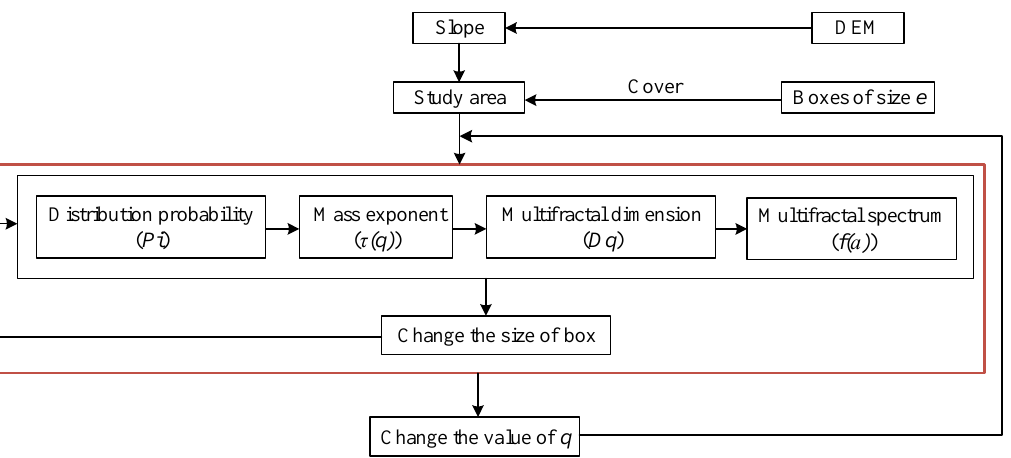
Figure 3. Workflow diagram of the multifractal analysis in this study.